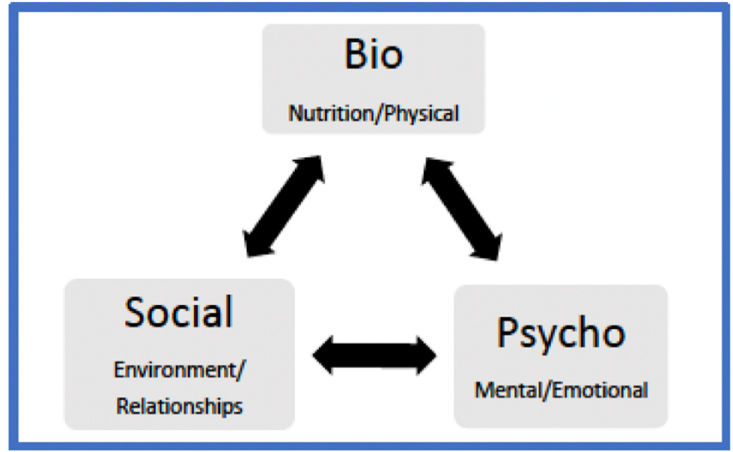
Figure 1. Example of Biopsychosocial Theoretical Pregnancy Model Incorporating Biological, Psy- chological, and Social Determinants of Health.